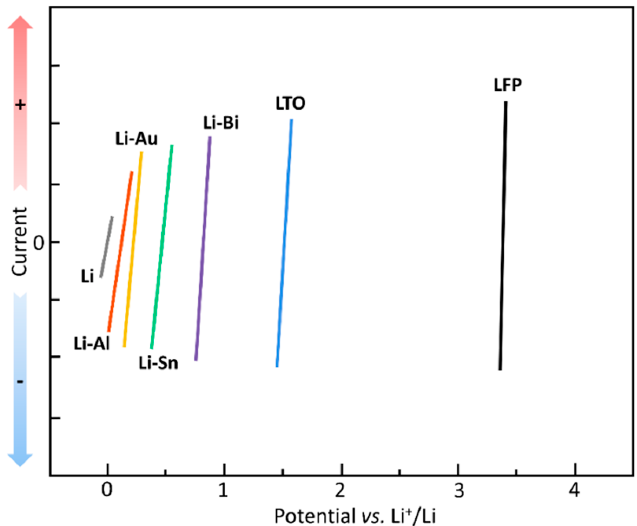
Figure 14. Comparison of typical polarization curves for various materials used in REs for LIBs.